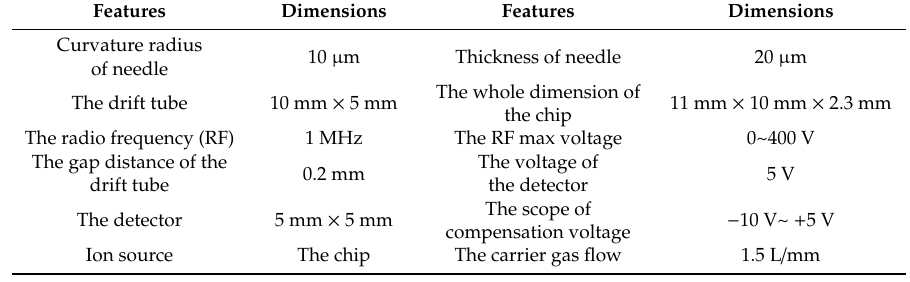
Table 2. Parameters of the high-field asymmetric ion mobility spectrometry (FAIMS)